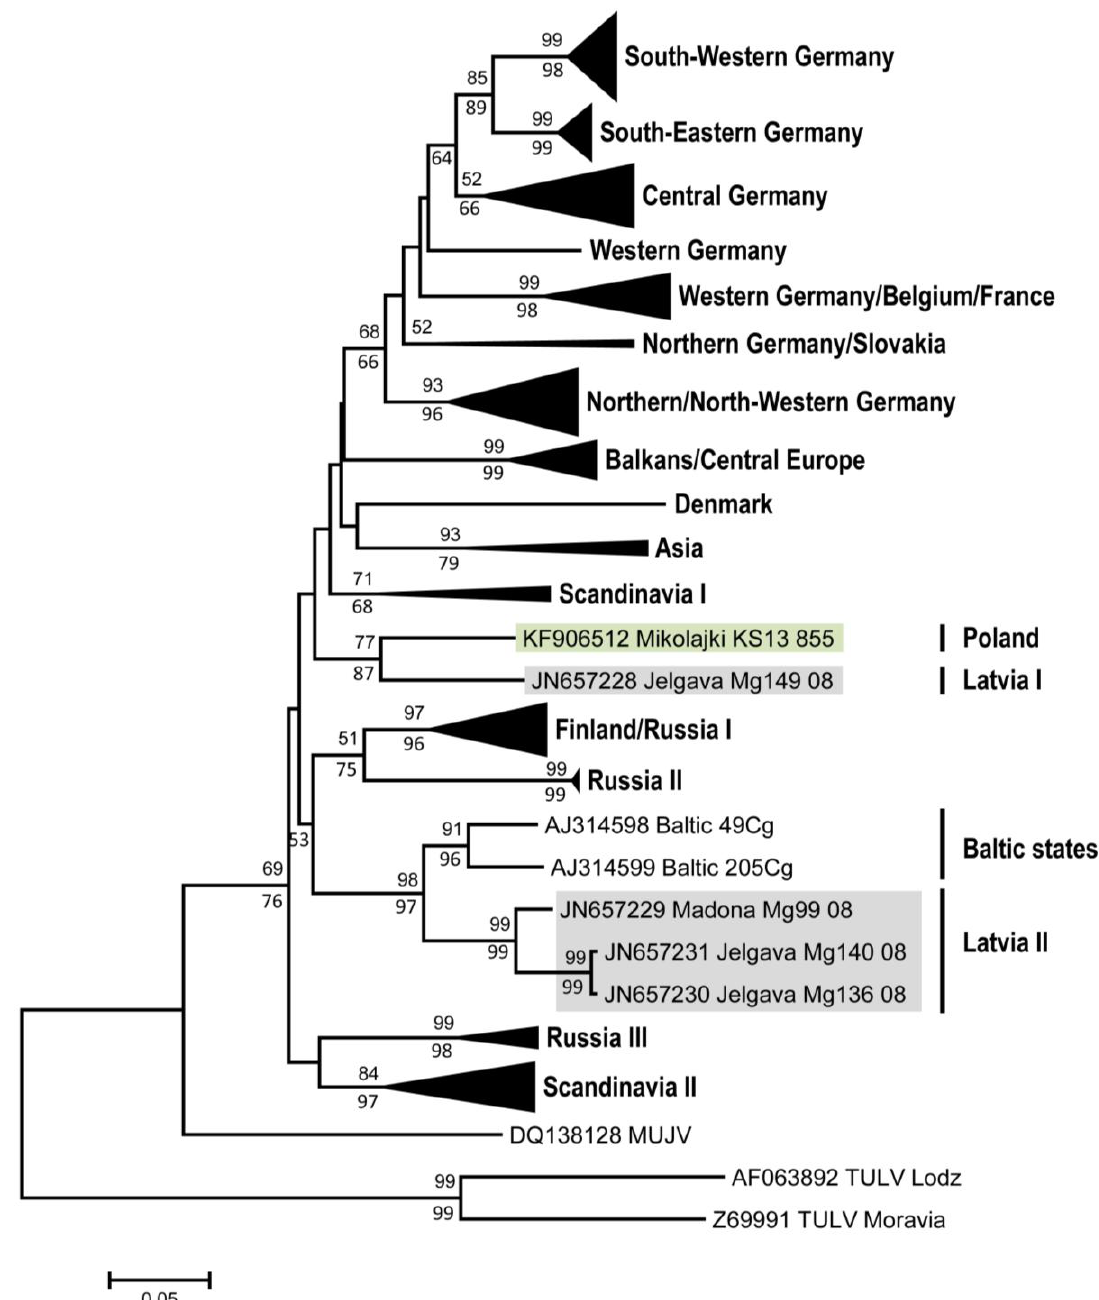
Figure 2. Phylogenetic relationships of Puumala virus sequences based on 465 nt of the S segment spanning positions 436–900 (numbering based on strain Sotkamo, accession number NC_005224) with Tula virus strains Lodz AF063892 and Moravia Z69991 as outgroup. The identical novel S segment sequence from the three bank voles (KS13/855, KS13/856 and KS13/861) in Mikołajki (Poland) and relevant sequences from Latvia (see Figure 1) are highlighted. Other geographical clusters of closely related sequences were condensed to triangles with sizes proportional to sequence numbers. Support values for Neighbor-Joining or Bayesian phylogenetic analyses are reported above/below branches of main nodes if they exceeded 50